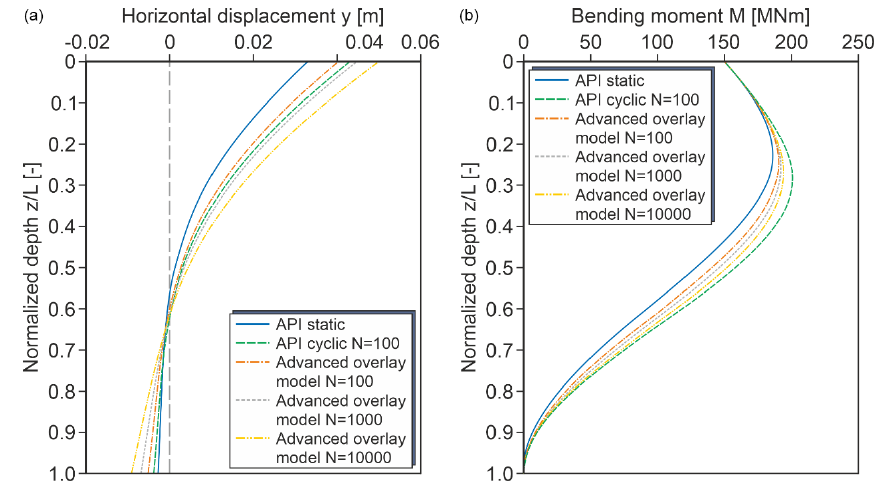
Figure 14. Comparison of pile deflection lines (a) and bending moments (b) .